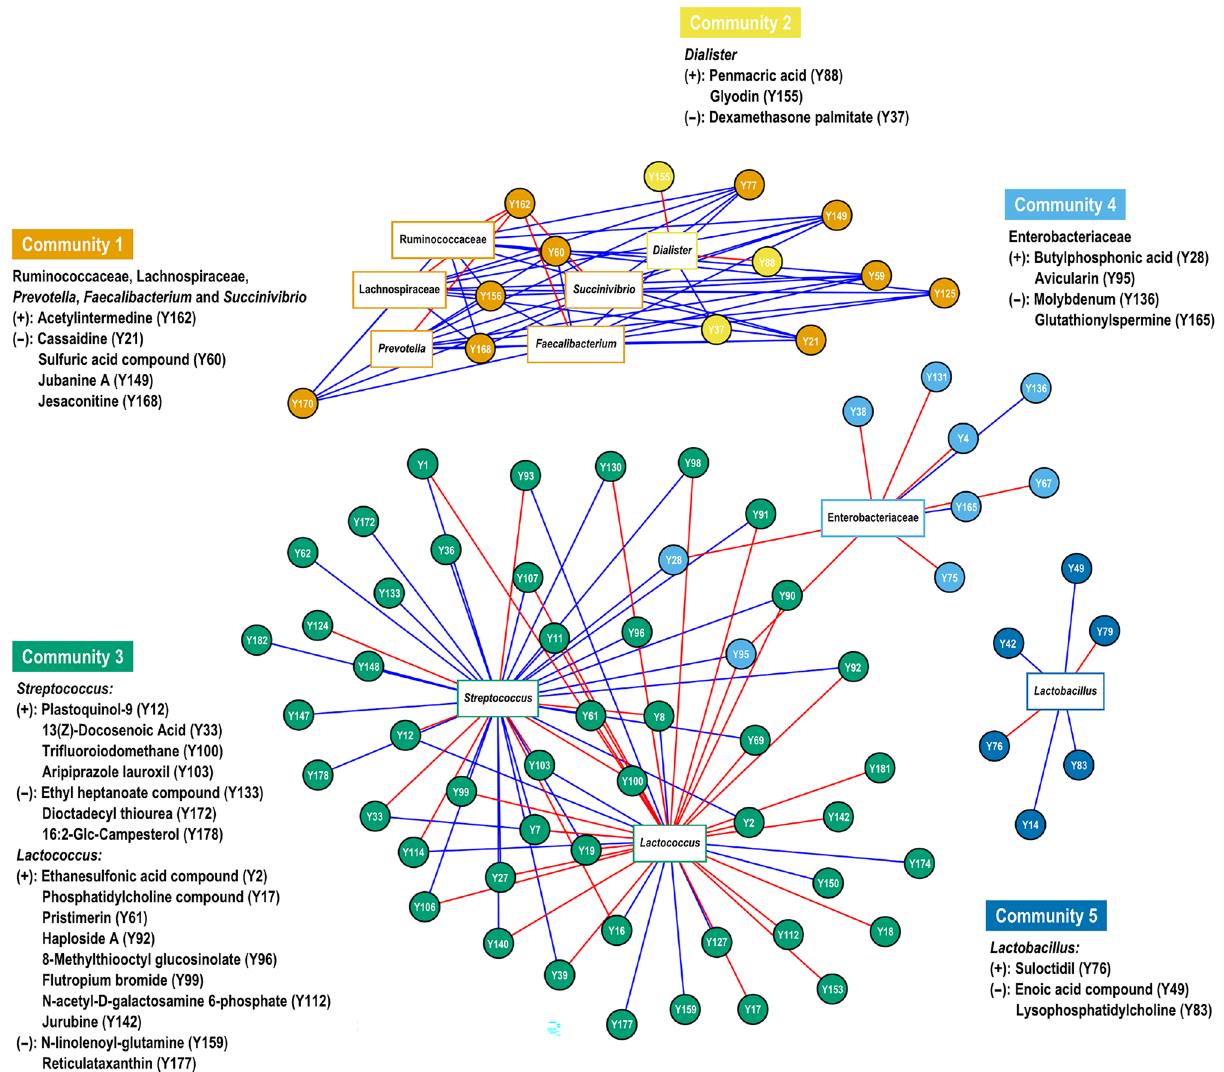
Figure 5. Multi-omics integration performed with xMWAS identified five communities. Encode name of metabolite features and bacterial are shown in circles and squares, respectively. Links indicate pairwise Pearson’s correlations (| r |> 0.40). Red links indicate a positive correlation, whereas blue links indicate a negative